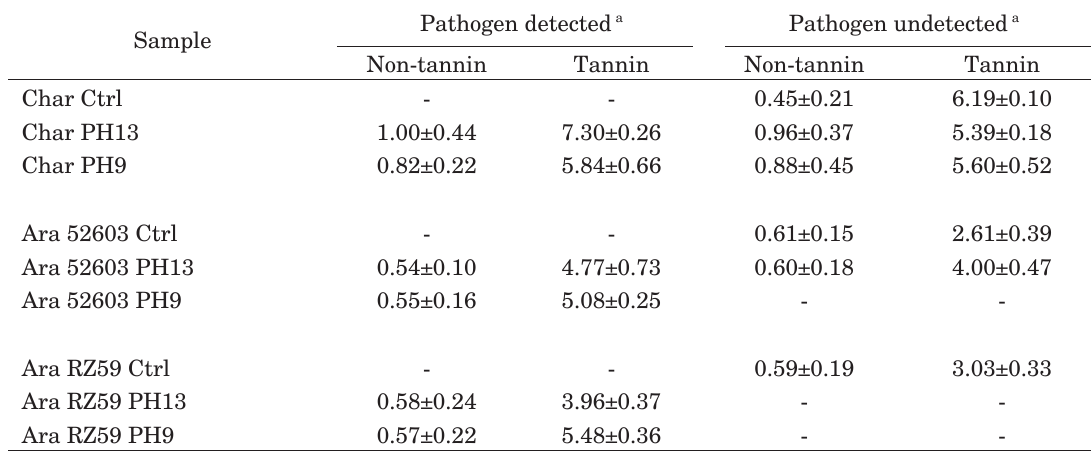
Table 4. Mean non-tannin and tannin content (mg g -1 wood) in healthy and infected plants from cv. Chardonnay (Char) and cv. Aragonez clones 52603 (Ara 52603) and RZ59 (Ara RZ59) infected at the shoot with Pa. chlamydospora strains PH13 and PH9. Results from control plants (Ctrl) are also